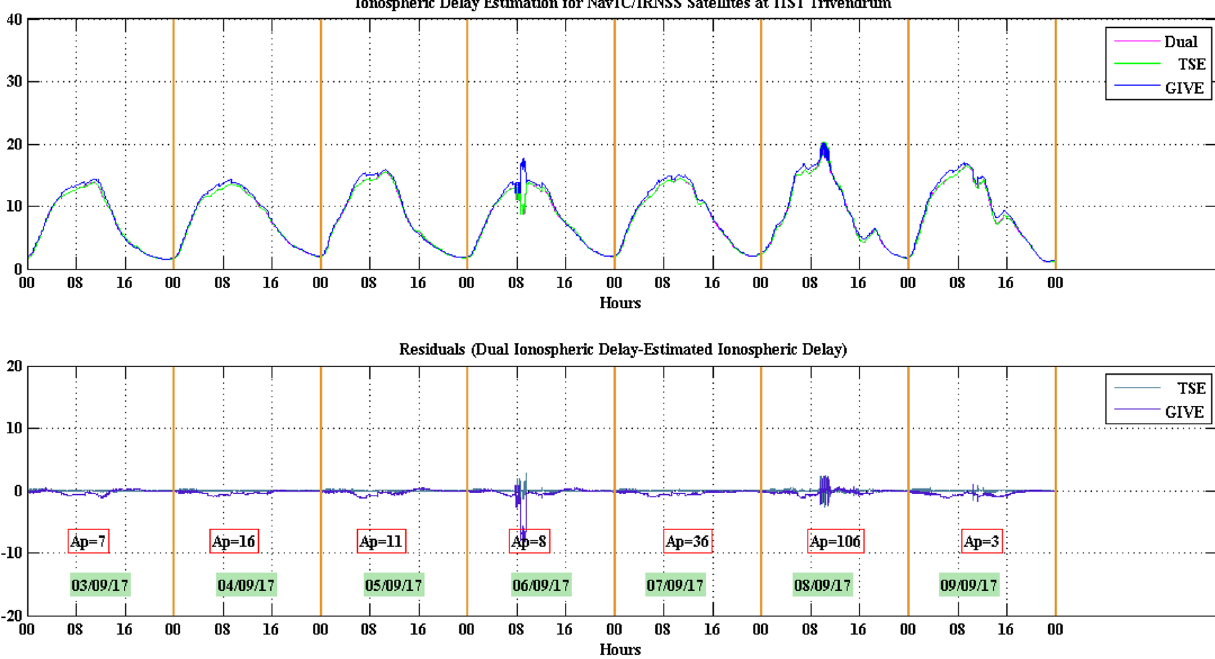
Fig. 11. The average ionodelay performance comparisons of TSE, dual frequency and GIVE model for NavIC/IRNSS satellites at the IIST Trivendrum on the observation duration (3 – 9 September 2017).